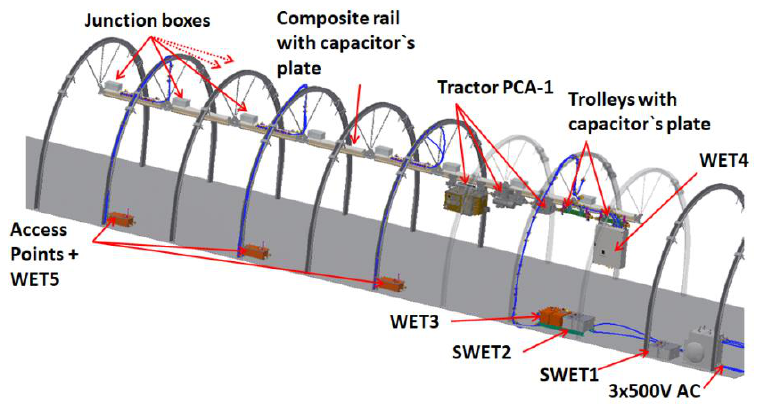
Figure 8. Visualization of the main modules associated with the WET system [16].